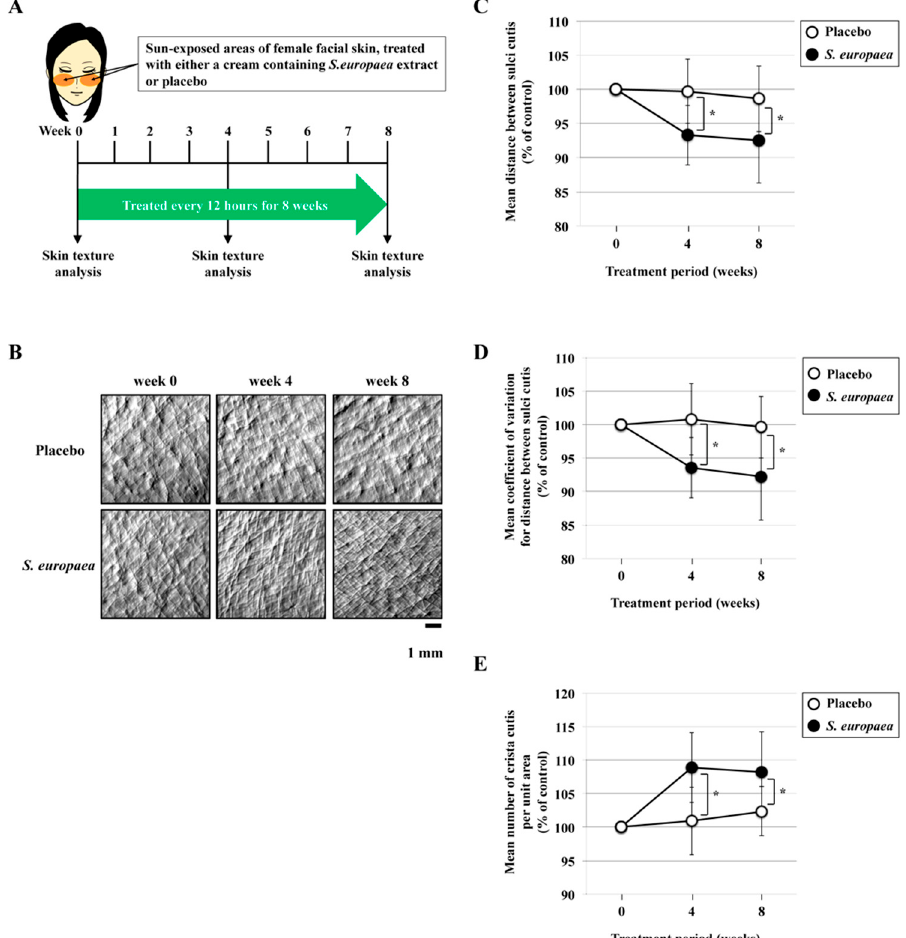
Figure 1. Improvements in the texture of the sun-exposed skin after treatment with S. europae . ( A ) Study design and treatment schedule. A cream containing S. europaea extract was topically applied to the facial skin in sun-exposed areas of 29 healthy volunteers, and simultaneously a placebo-controlled trial was carried out with the same subjects, on the contralateral side of the face. All volunteers underwent twice-daily treatments for 4 and 8 weeks. The skin texture was analyzed before and at 4 and 8 weeks after the treatment. ( B ) Typical reflective replica images from skin treated either with S. europaea extract, or placebo. The images were obtained using 3D Skin Roughness Analysis Measurement System. Scale bar, 1000 µ m. ( C ) E ff ects of S. europaea on the distance between sulci cutis. The data were obtained from three di ff erent areas (50 mm × 50 mm) of each skin sample from 29 subjects. Values indicate means ± S.D. * p < 0.02. ( D ) E ff ects of S. europaea on coe ffi cient of variation between sulci cutis in the above data. Values indicate means ± S.D. * p < 0.007. ( E ) E ff ects of S. europaea on number of crista cutis per unit area. The data were obtained from three di ff erent areas (50 mm × 50 mm) of each skin sample from 29 subjects. Values indicate means ± S.D. * p <